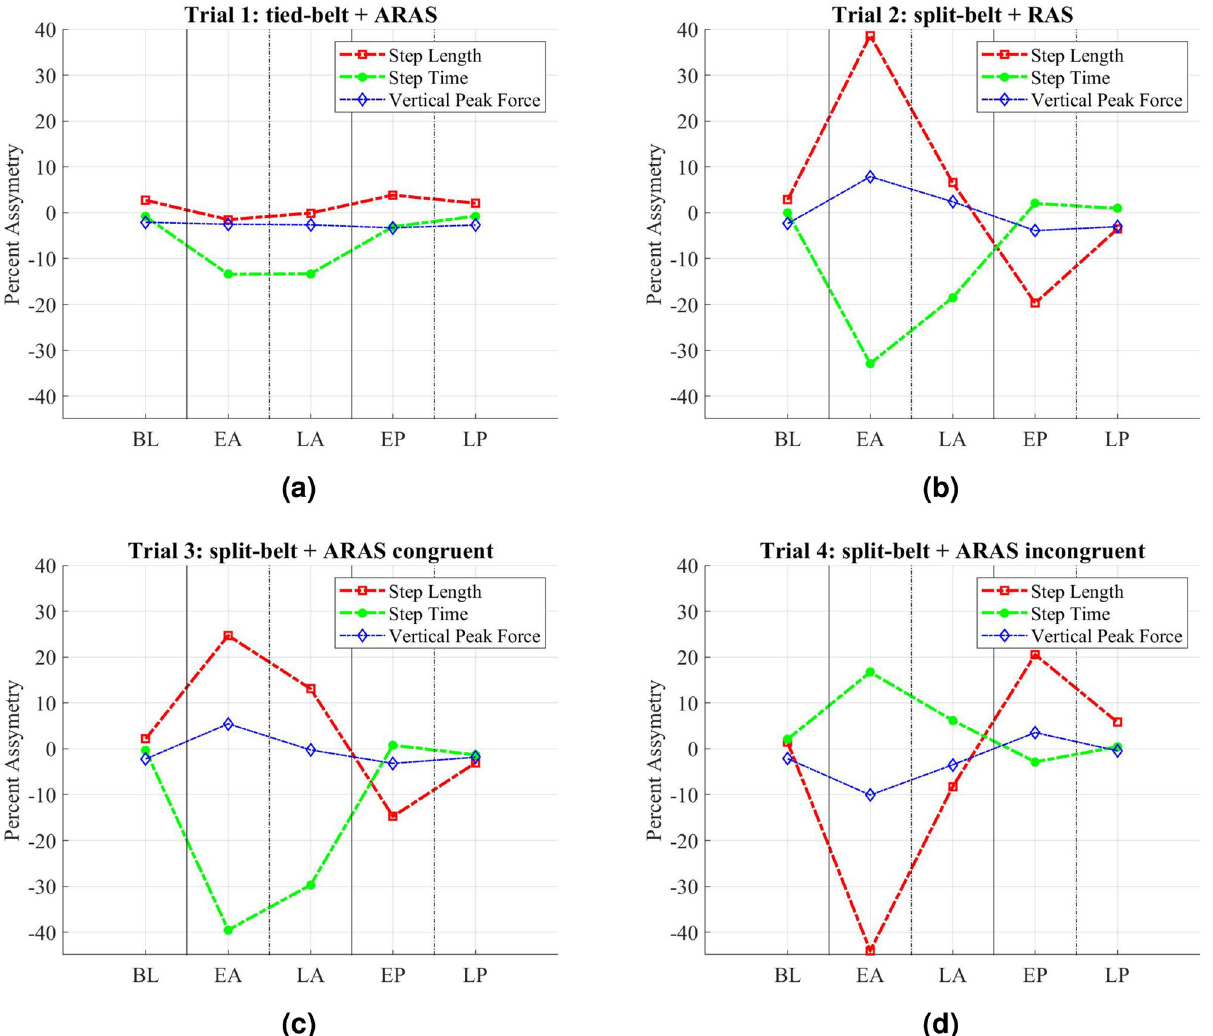
Figure 3. Percent asymmetry average of step length, step time, and peak vertical force during five time- windows ( BL baseline, EA early adaptation, LA late adaptation, EP early post-adaptation, LP late post- adaptation) for group A. Solid vertical lines indicate the start and stop of each phase. ( a ) Trial 1: tied-belt + ARAS, ( b ) Trial 2: SBT + RAS, ( c ) Trial 3: SBT + ARAS congruently, ( d ) Trial 4: SBT + ARAS incongruently. In trials 1 and 2 (top row) only one intervention was applied asymmetrically while both interventions were asymmetric in trials 3 and 4 (bottom